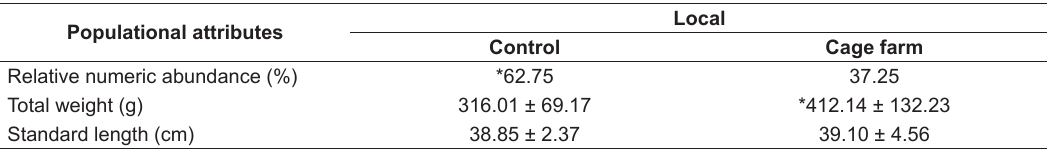
Table 2. Relative numeric abundance and medians for total weight and standard length ± interquartile deviation of